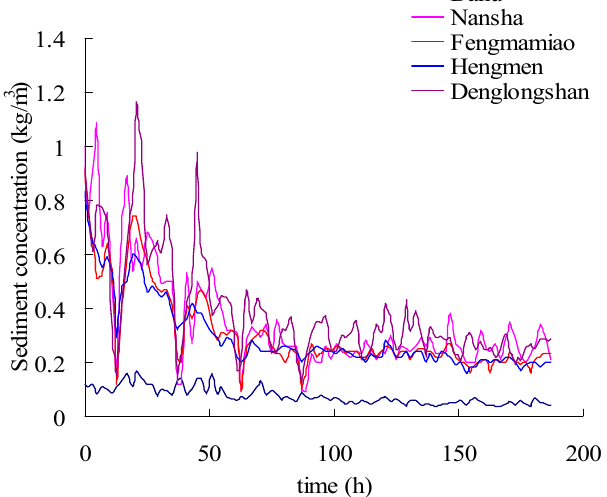
Figure 7. Sandbar simulation: boundary conditions of sediment concentration for the sediment model.